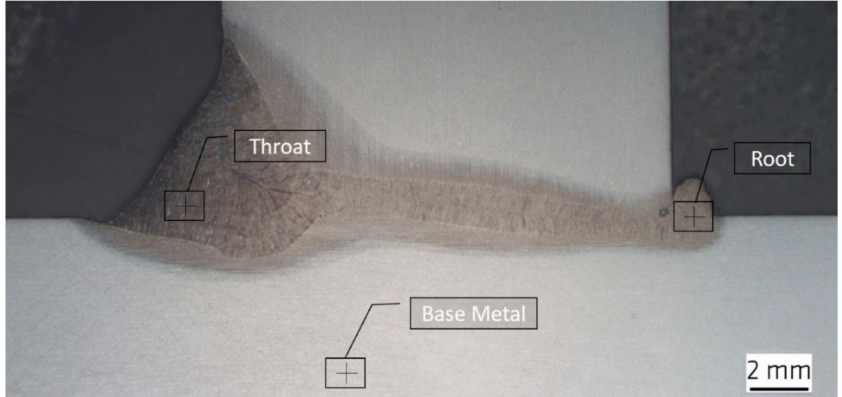
Figure 9. Representative EDS spectra at the laser zone.